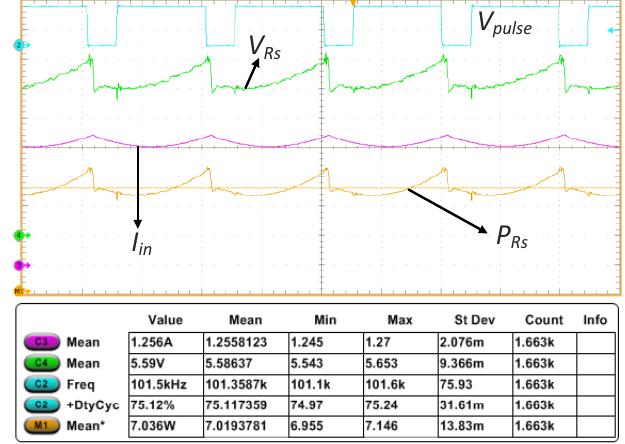
Figure 16. Internal resistance voltage graph.